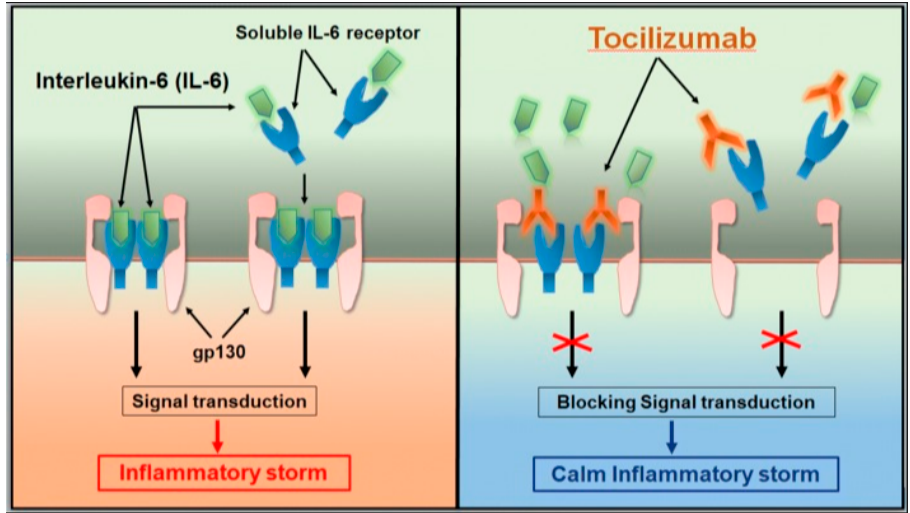
Figure 2. Tocilizumab calms the inflammatory storm through blocking IL ‐ 6 receptors [18].